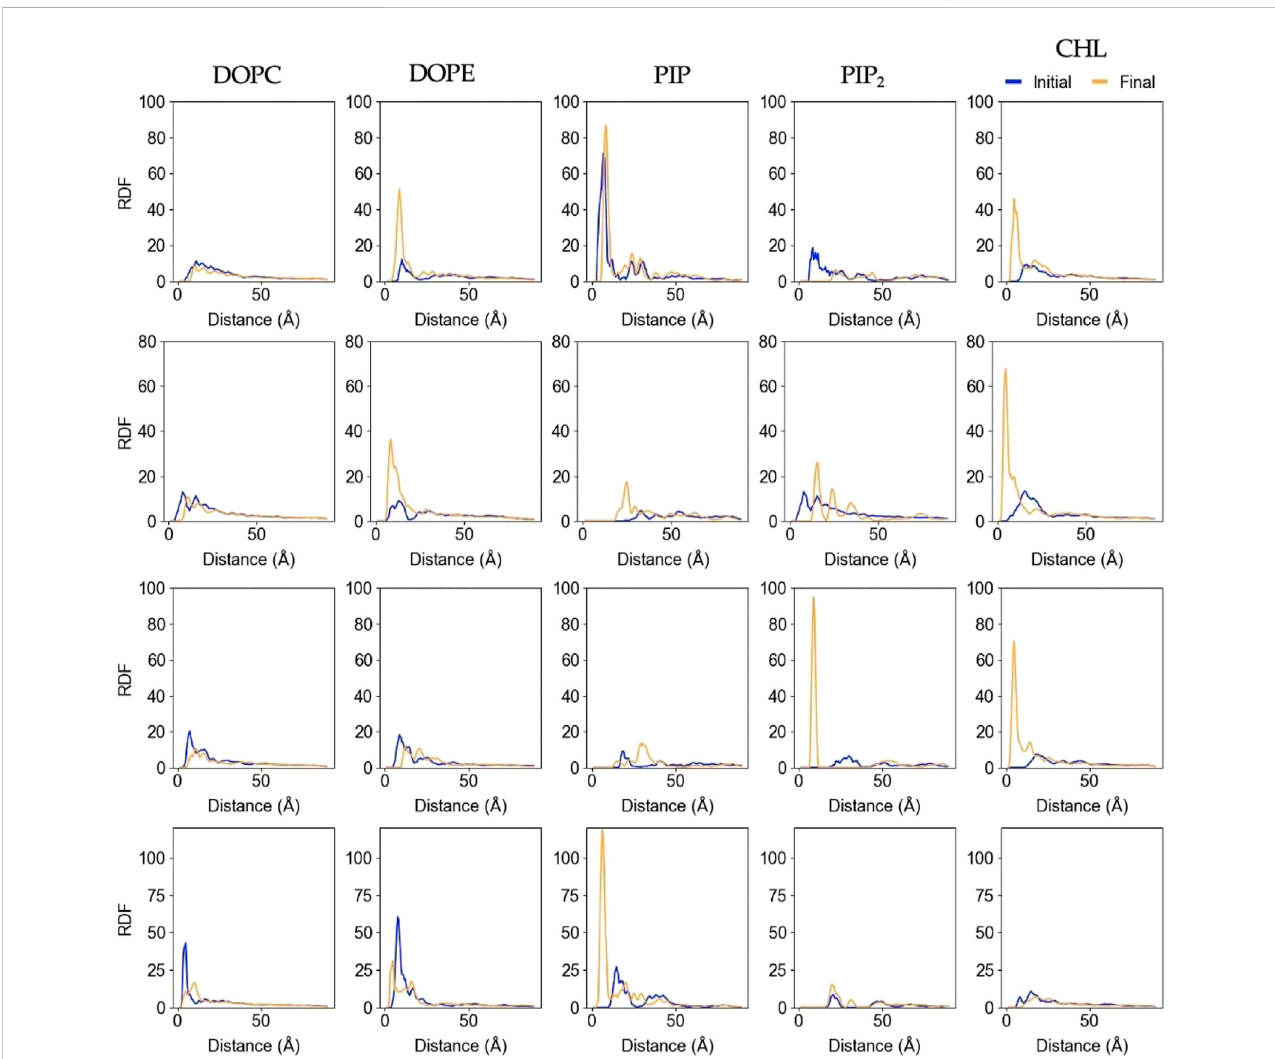
FIGURE 6 Lipid-Protein RDFs for each lipid species upon protein binding and at the end of the trajectory. The analysis was performed between the C α atom of the deepest inserted protein residue in each replica (Rep1: K268, Rep2 and Rep3: Q53, and Rep4: G406), and the phosphorus (P) or hydroxyl oxygen (O3) of the lipids and cholesterol molecules, respectively. Initial curve is the averaged behavior during the fi rst 50ns upon protein binding (shown in blue), and fi nal is the average behavior over the last 100ns of simulation (shown in orange). Each row corresponds to Rep1-4, and each column corresponds to the lipid species listed at the